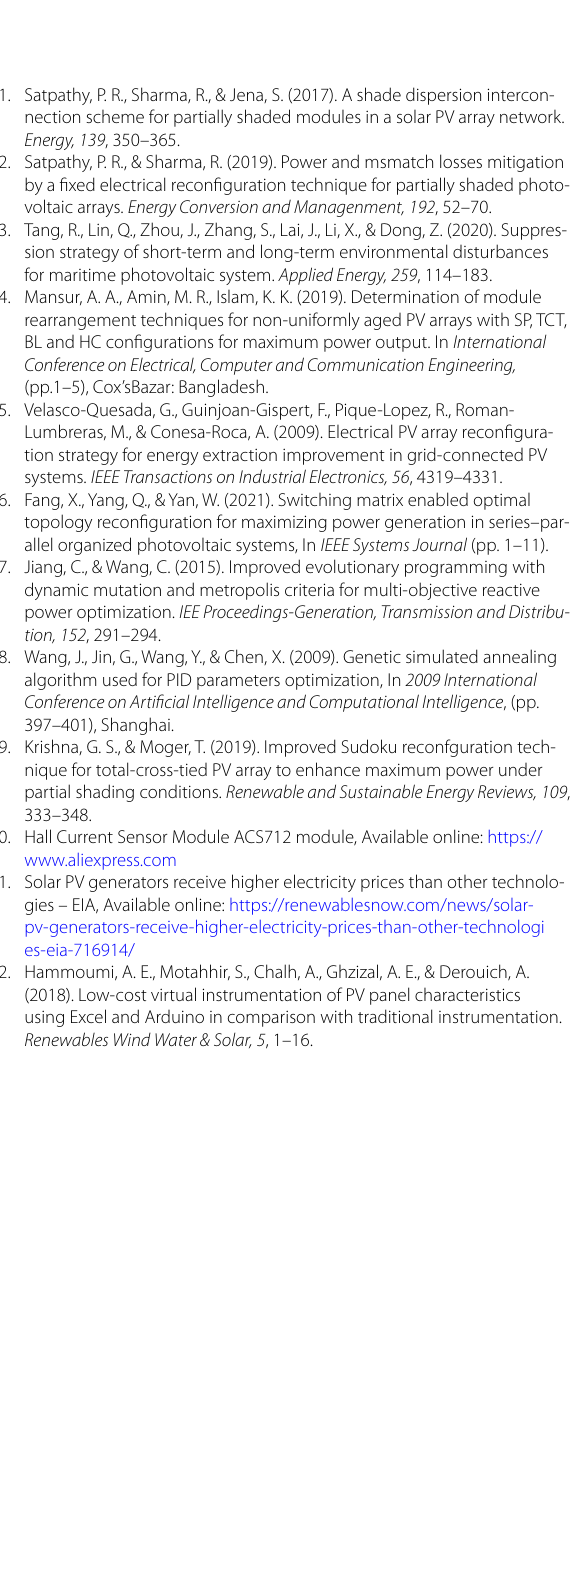
figuration process. Energy Conversion and Managemen . https:// doi. org/ 10. 1016/j. encon man. 2020.